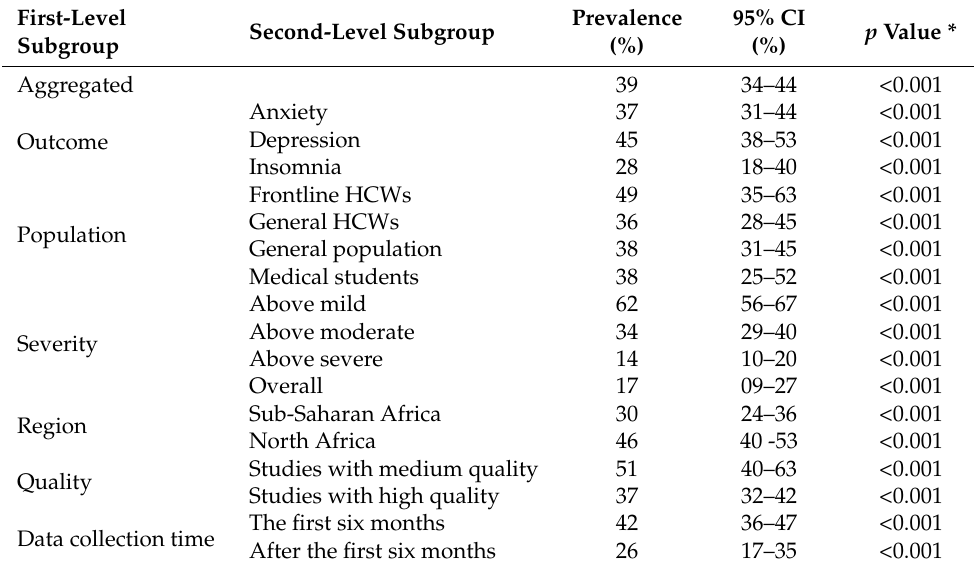
Table 2. The pooled prevalence rates of mental health symptoms by subgroups of population, outcome, and